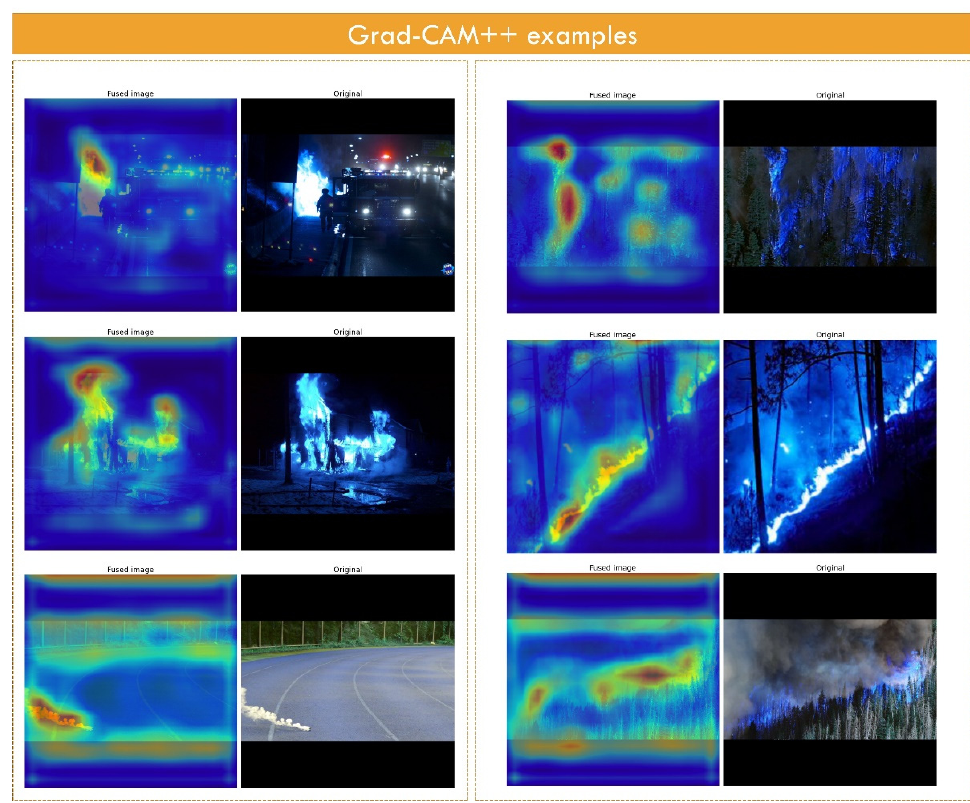
Figure 3. Random samples from the Grad-CAM++ assisted output of Xception CNN. The red color implies areas of high significance according to the model. Green implies medium significance and blue minor sigificance.